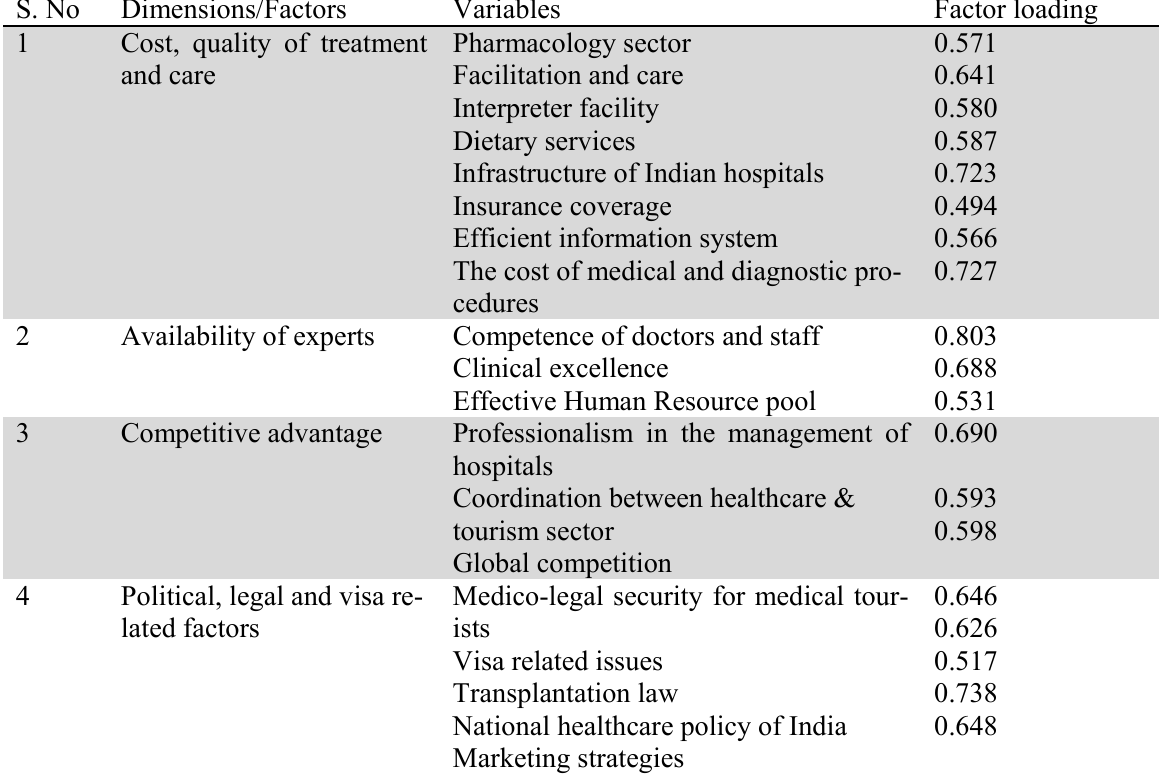
Factors/Dimensions of Indian Medical Tourism sector S.